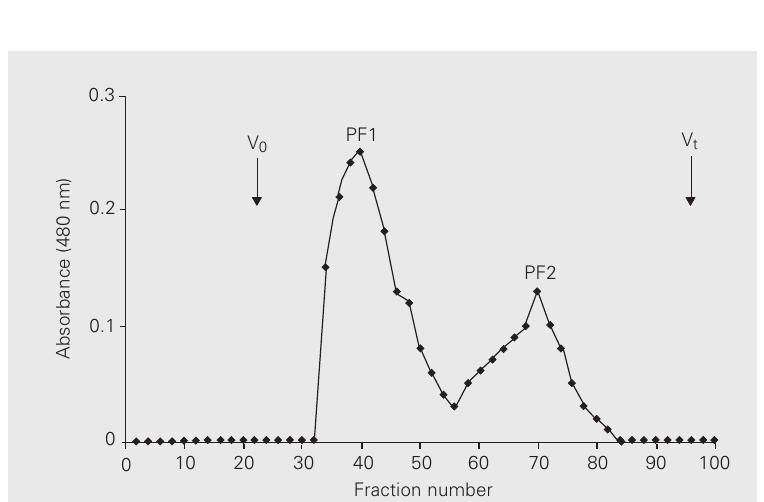
Figure 1. Agarose gel electrophoresis of sulfated fucans extracted from Padina gymnospora. Sulfated fucans were extracted after maxataze digestion and partially purified by acetone precipitation. The sulfated fucans (50 µg) were applied to 0.5% agarose, and electrophoresis was carried out for 1 h at 110 V in 0.05 M 1,3-diaminopropane/acetate, pH 9.0. Gels were then maintained in 0.1% N-cetyl-N,N,N-trimethylam- monium bromide solution for 4 h and dried. The poly- saccharides in the gel were stained with 0.1% Tolui- dine blue in acetic acid/ethanol/water (0.1:1:5, v/v) for 15 min and destained with acetic acid/ethanol/water (0.1:1:5, v/v) (A) or with 0.1 M sodium acetate, pH 4.0, in water for 5 min (B). Standard of glycosaminogly- cans: chondroitin sulfate (CS), dermatan sulfate (DS) and heparan sulfate (HS), 5 µg each. OR = origin. The